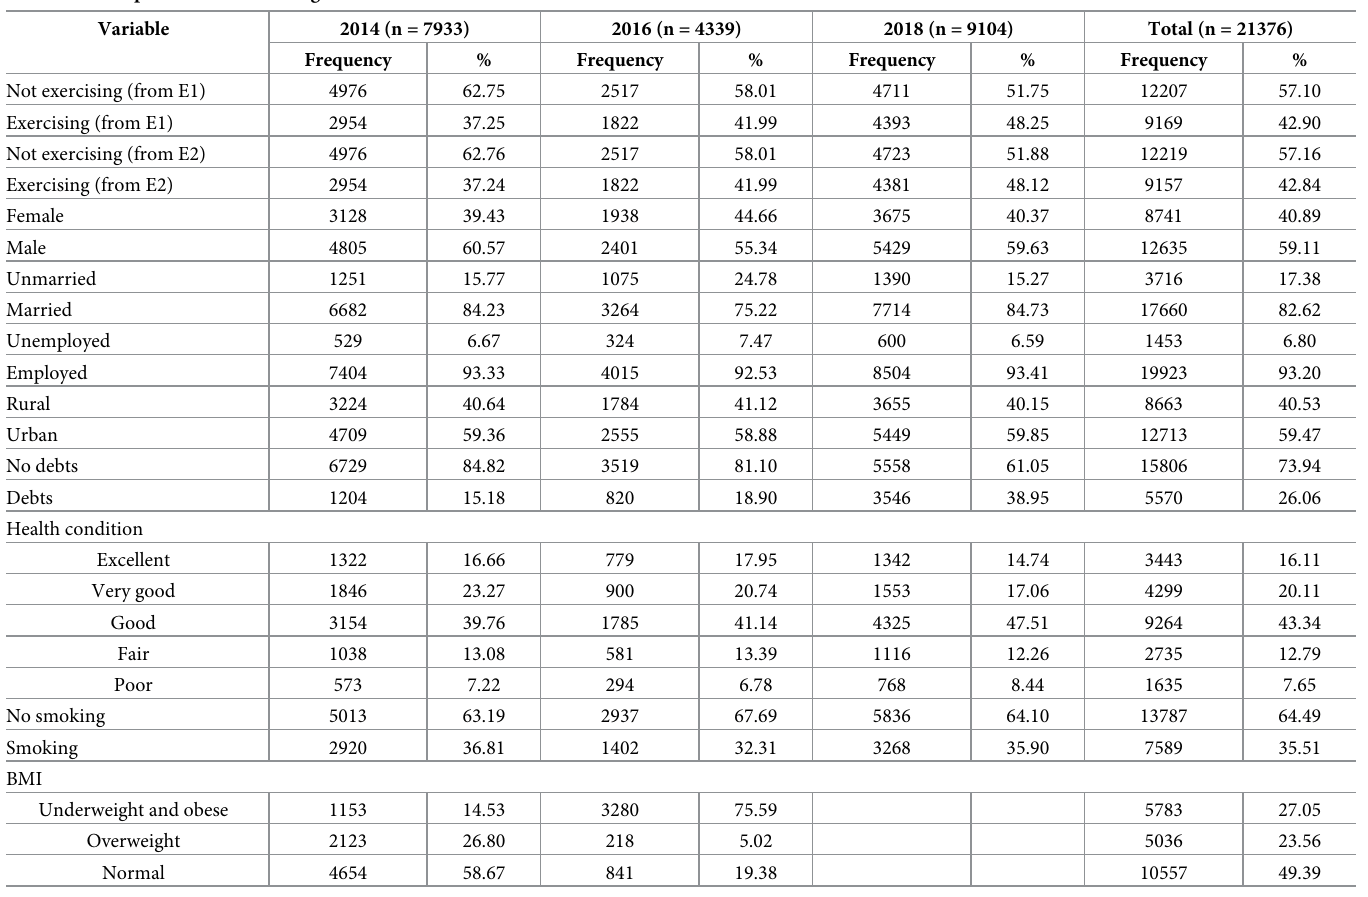
Table 3. Descriptive statistics of categorical